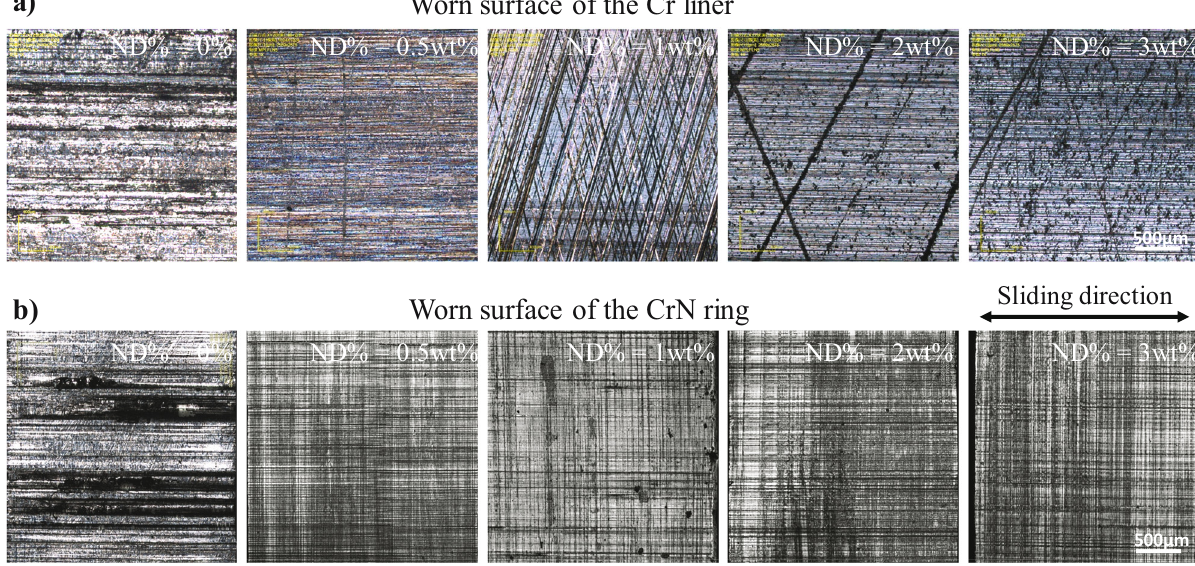
Figure 7: Worn micrographs of the Cr liner ( a ) and its counterpart CrN piston ring ( b ) lubricated with di ff erent ND content lubricants.